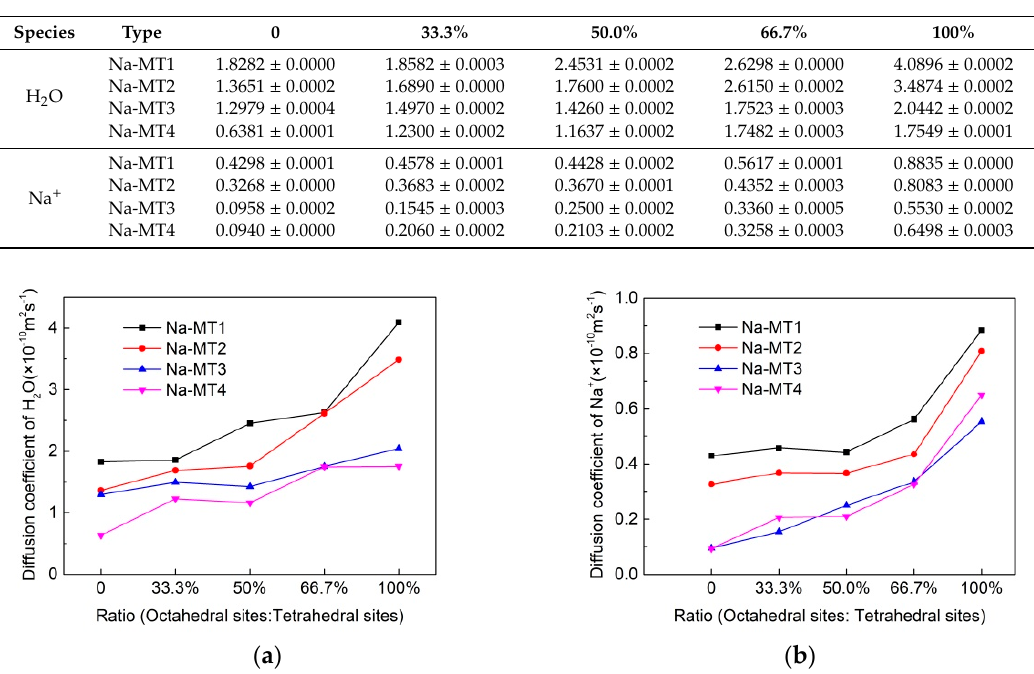
chemistry properties (unit: × 10 − 10 m 2 / s, and the standard error were generated from linear fitting in Origin 9.0 and please see details in the Supplementary Materials).